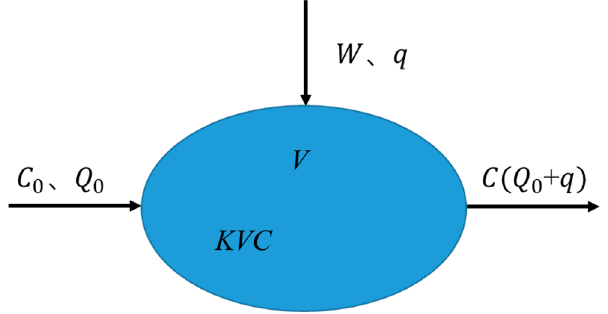
Figure 8. Zero-dimensional model schematic.